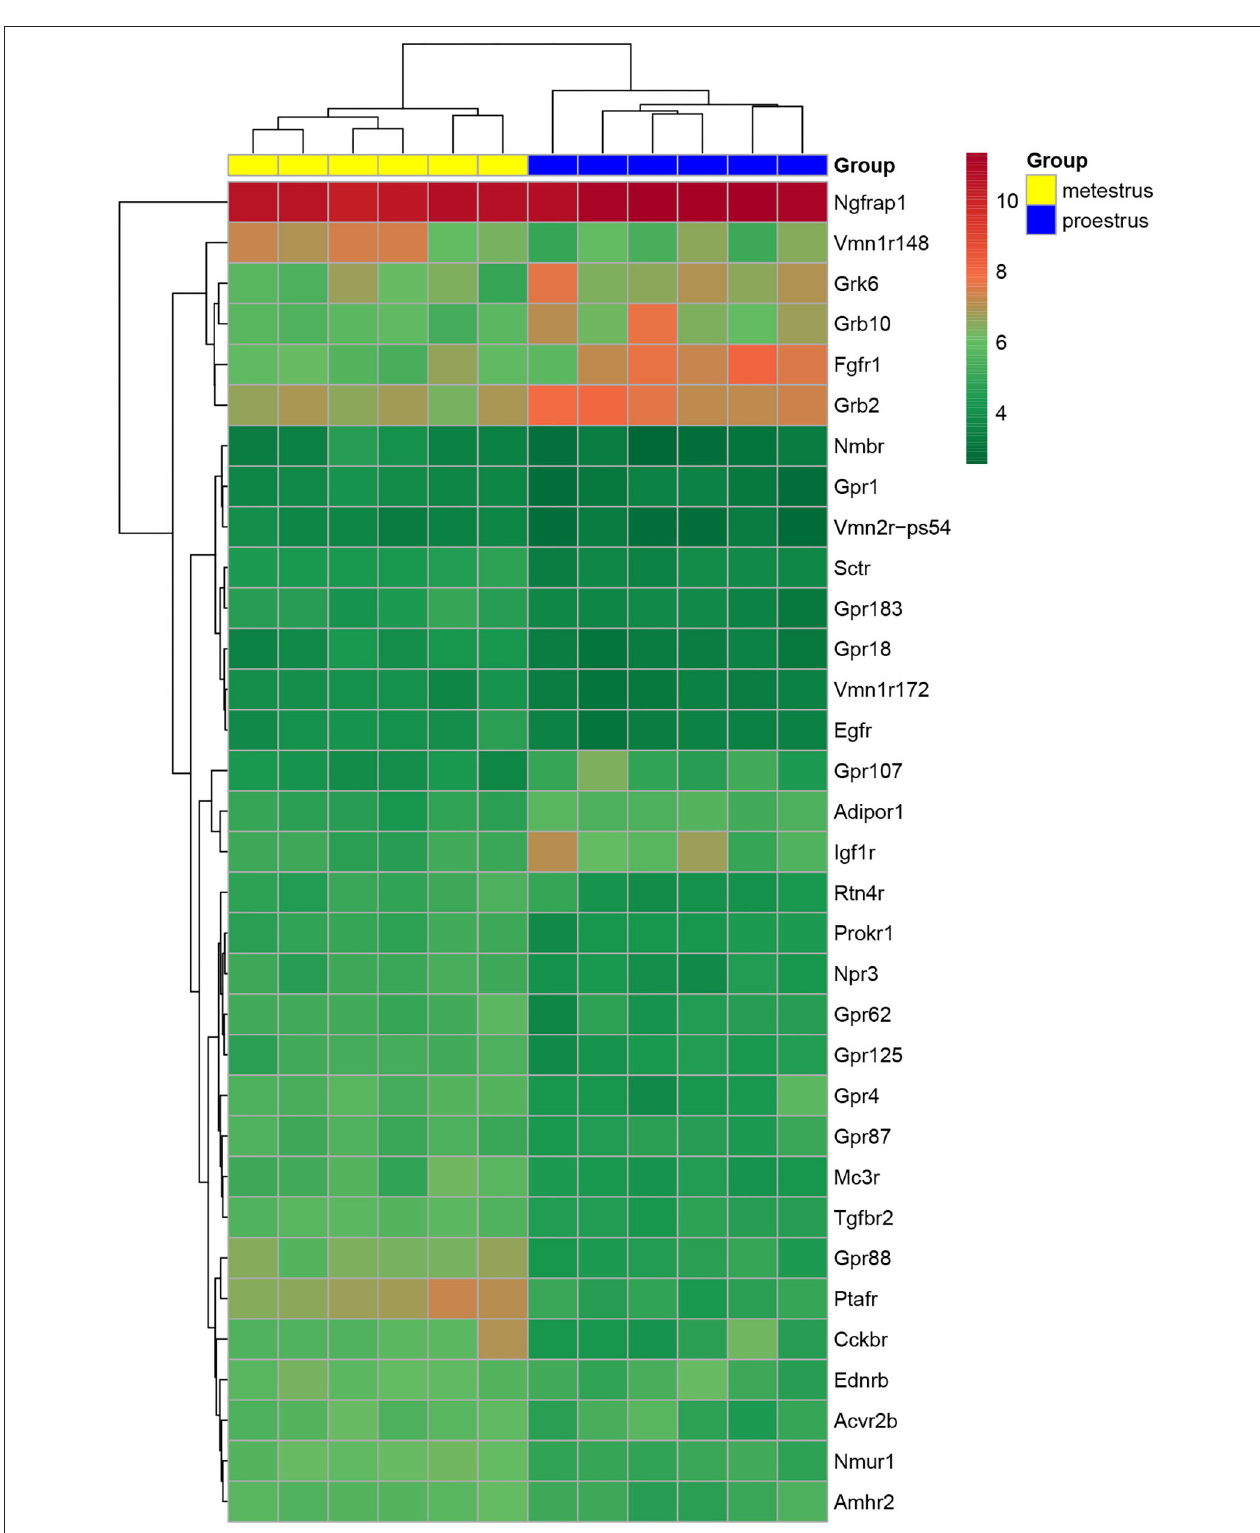
FIGURE 1 | Heat map of peptide/neuropeptide, growth factor, and orphan G-protein-coupled receptor genes regulated differentially in GnRH neurons of proestrous vs. metestrous mice. Expression levels of involved in signaling mechanisms. The rows represent differentially expressed probe sets with corresponding gene symbols on the right. The expression level of each probe is color coded. For decoding, see the color key. The individual samples are shown as columns. The six metestrous and six proestrous samples are coded in yellow and blue, respectively.